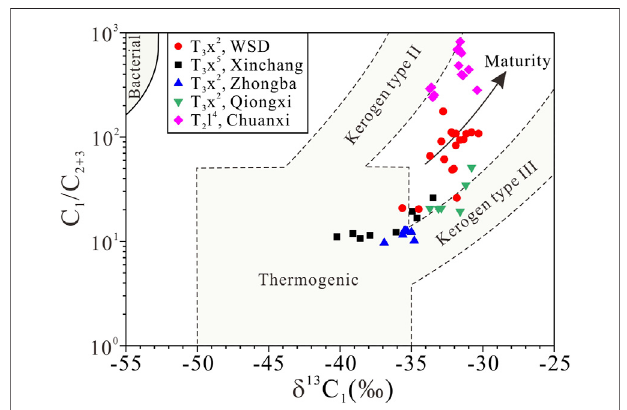
FIGURE 4 | The diagram of C 1 /C 2+3 versus δ 13 C 1 of the T 3 x 2 gas from the Western Sichuan Depression (modi fi ed after Bernard et al., 1976).